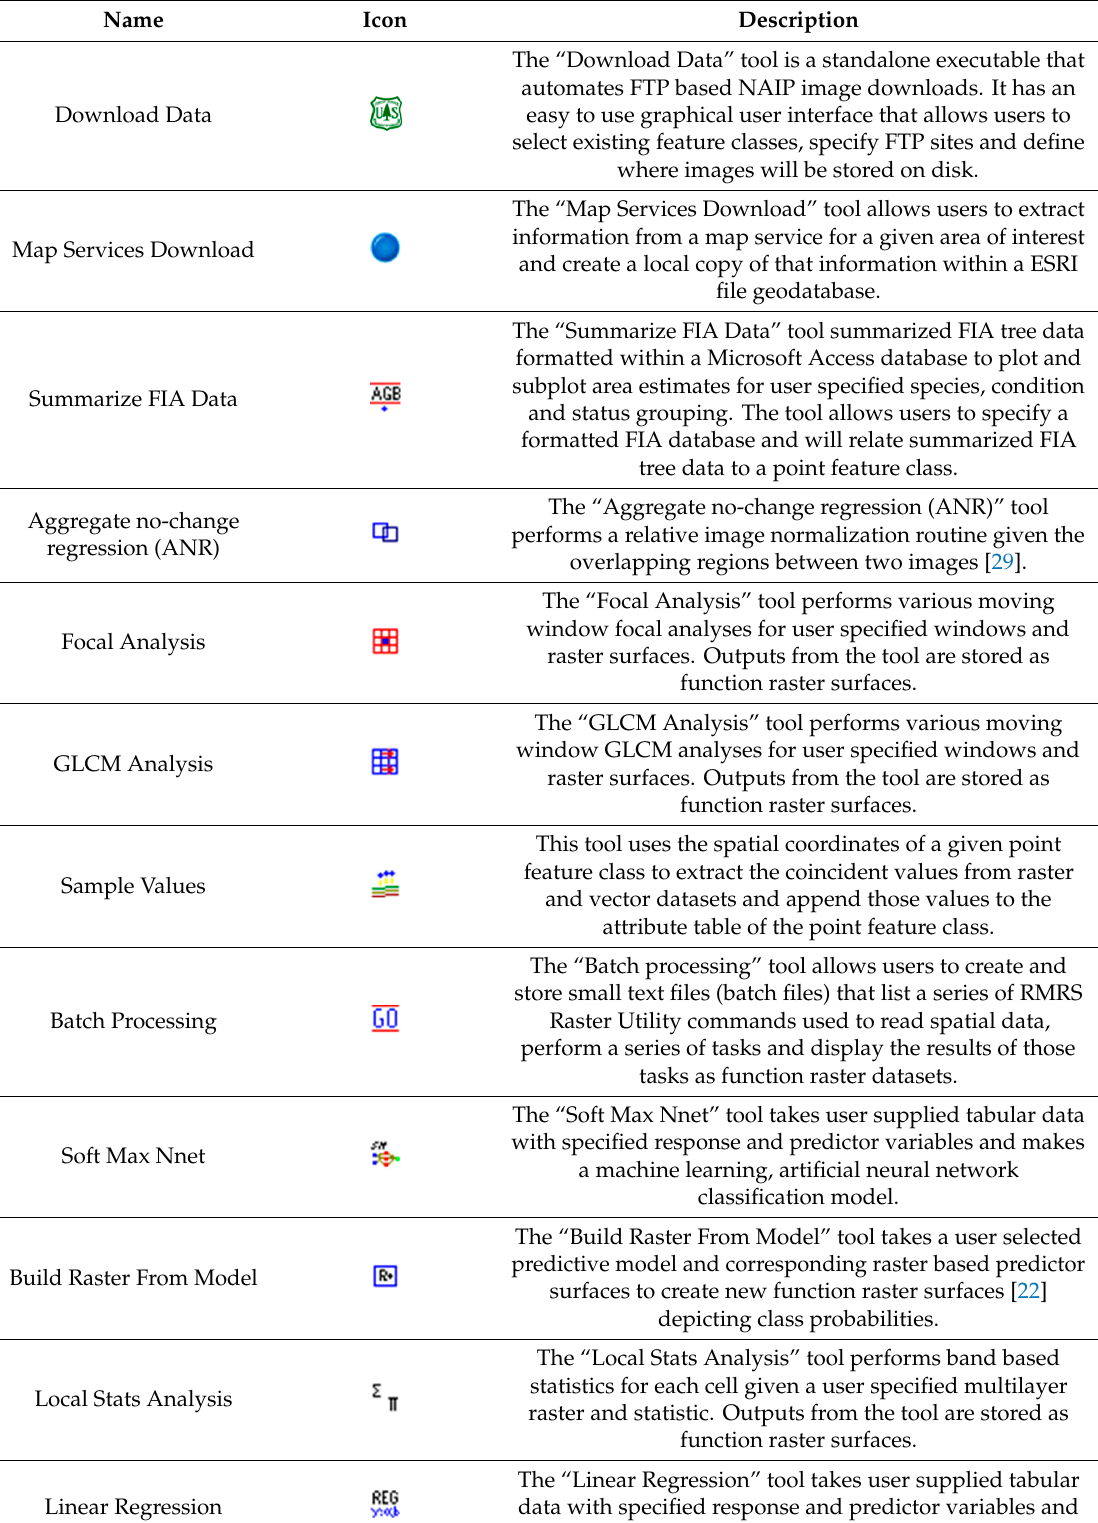
Table A1. List of newly developed tools integrated into the RMRS Raster Utility toolbar and used to faciliate raster and vector based processing.